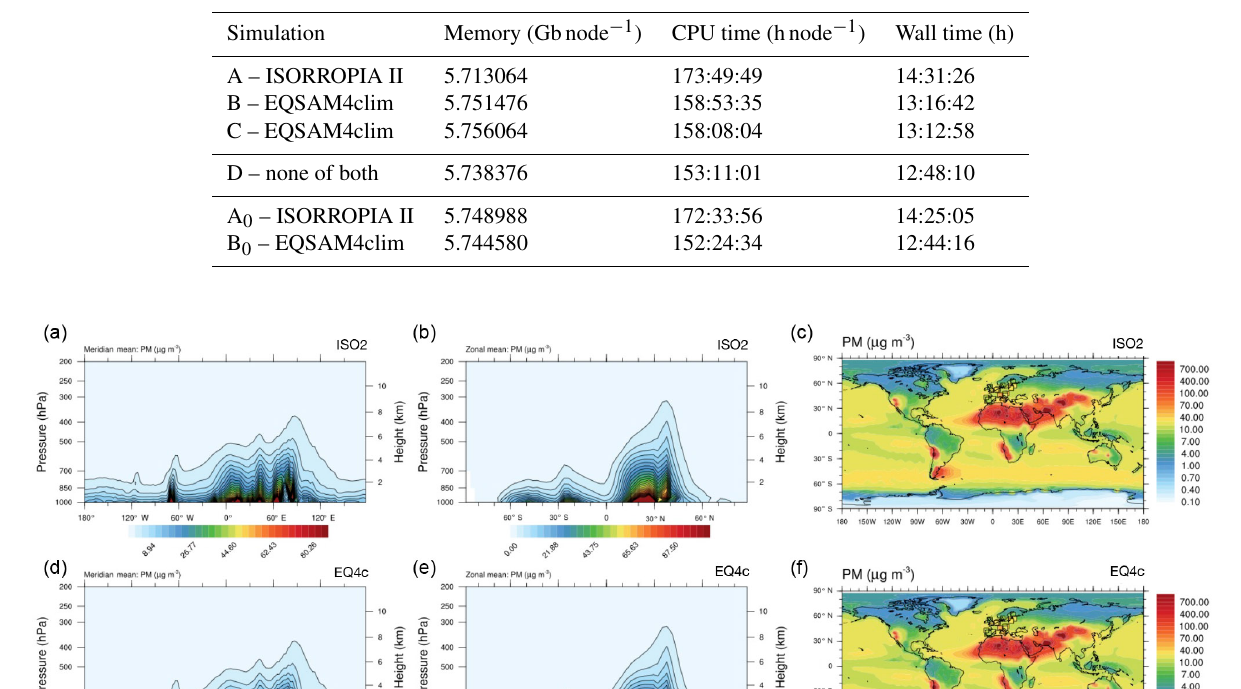
Table 5. CPU times. EMAC @ 96 CPU cores, Cy-Tera (http://web.cytera.cyi.ac.cy/, last access: 23 November 2018).